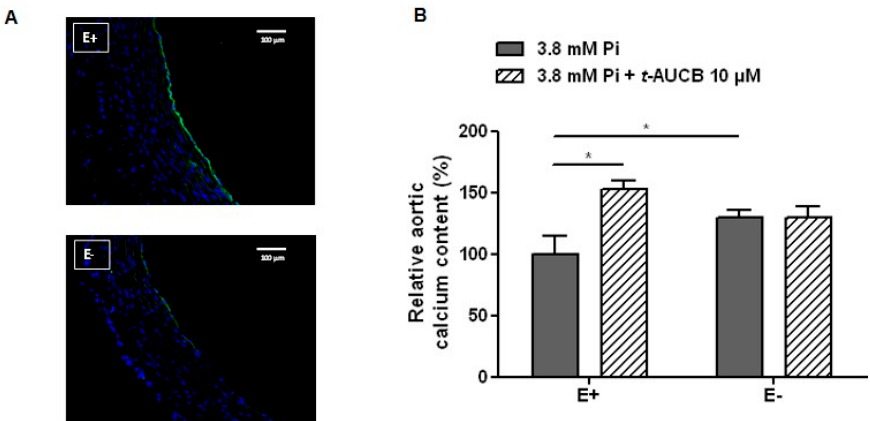
Figure 3. Representative images of CD31 immunostaining ( A ) and relative calcium content of intact (E + ) and deendothelialized (E − ) aortic rings cultured for 7 days in 3.8 mM Pi in the absence and in the presence of 10 µ M t -AUCB (( B ) n = 3–8 per group). * p < 0.05.